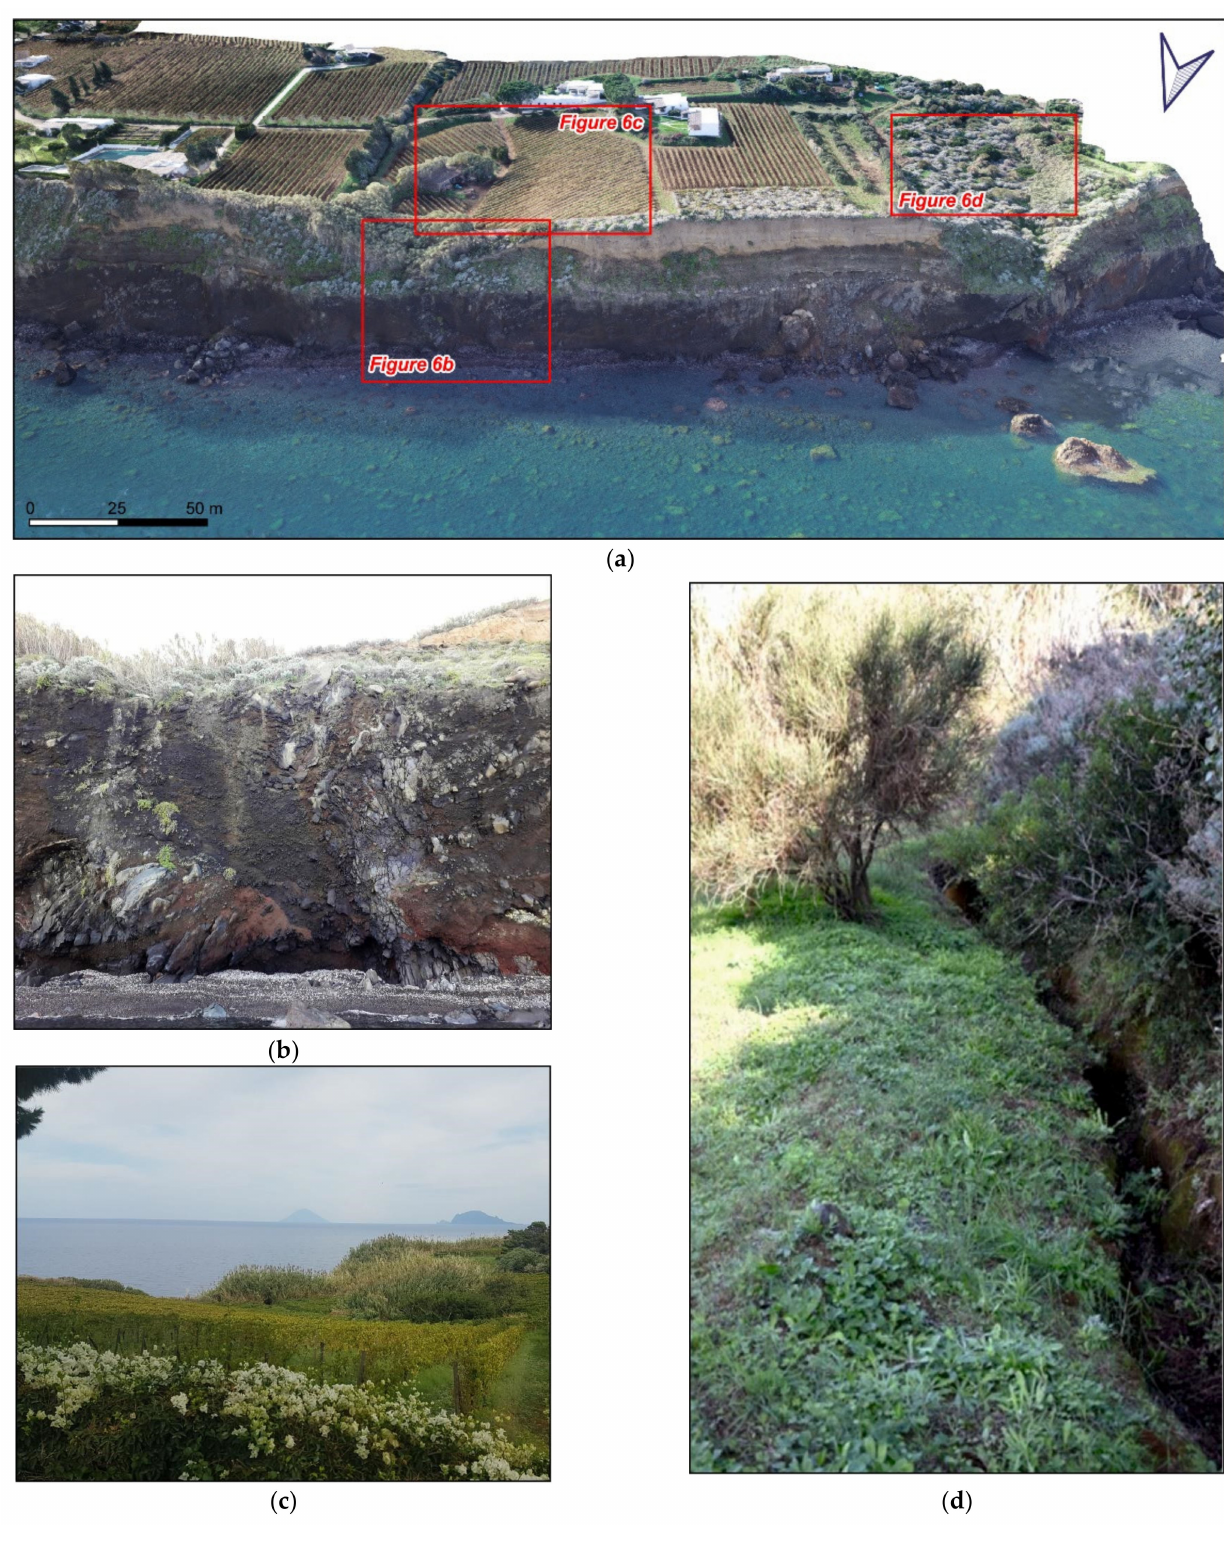
Figure 6. ( a ) 3D textured model focused on the intense gully erosion affecting the flat land right behind the edge of the coastal cliff. ( b – d ) shooting areas are indicated by red squares; ( b ) Hanging valley at the outlet of a wide channel. The erosive action of water caused the alteration of the pyroclastic deposits of the cliff; ( c ) The vineyard of Capo Faro Estate gently slopes into the hanging valley of ( b ); ( d ) The deep groove of a gully caused by runoff